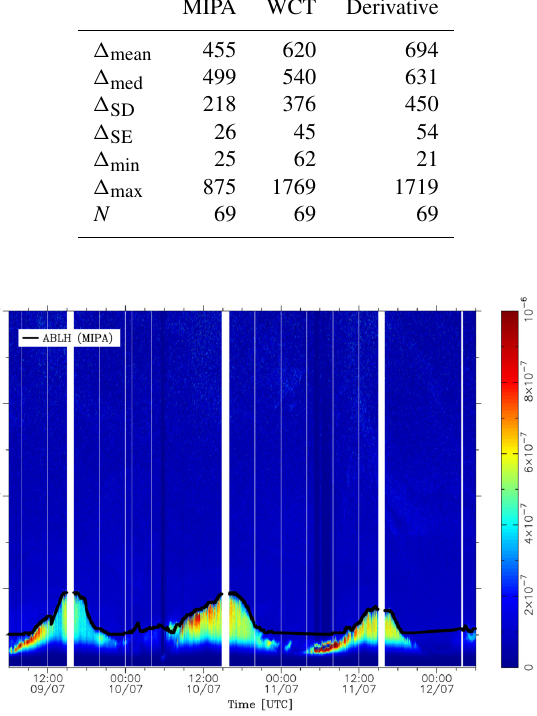
Figure 5. High-resolution time series of the total attenuated backscatter at 1064nm measured over Évora during the EARLINET 72h exercise (9–12 July 2012). Time resolution is 30s, vertical res- olution is 30m. The black curve shows the ABLH as retrieved by the MIPA